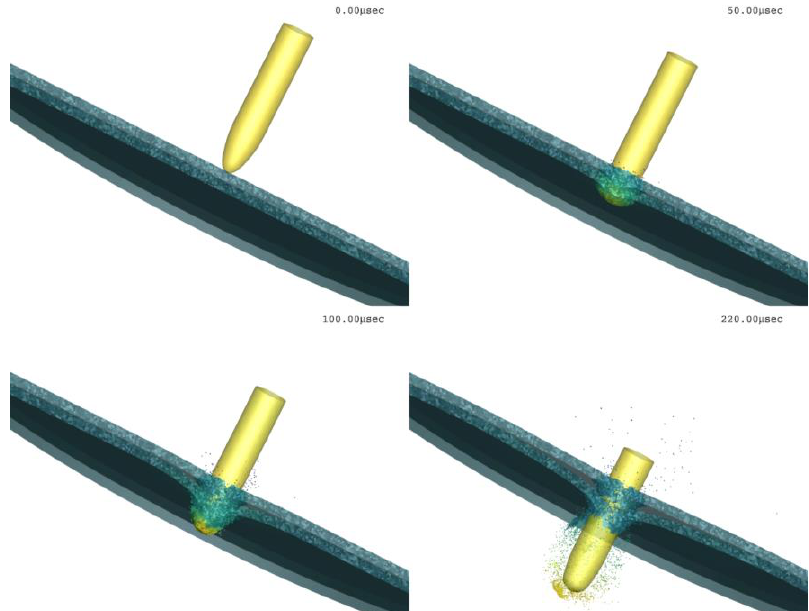
Fig. 4. The process of perforation of two-layer steel barrier with contact of the